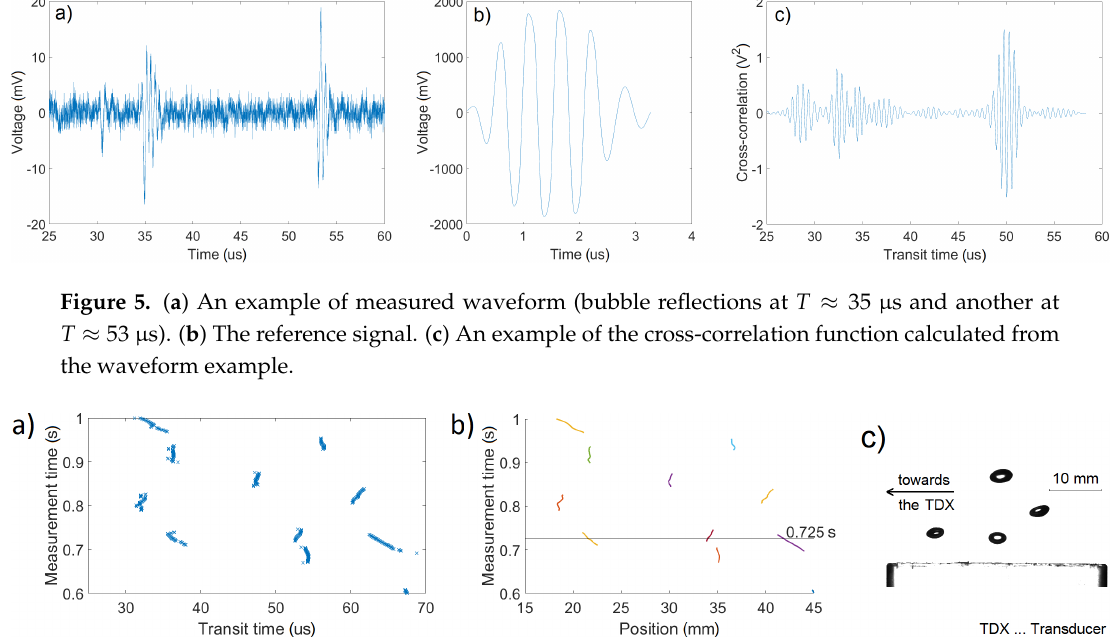
Figure 6. Example of results for case 9: ( a ) Points detected by pulse-echo. ( b ) Trajectories connected by the tracking technique. ( c ) HSC image for t = 0.725 s. The top bubble has already left the sound